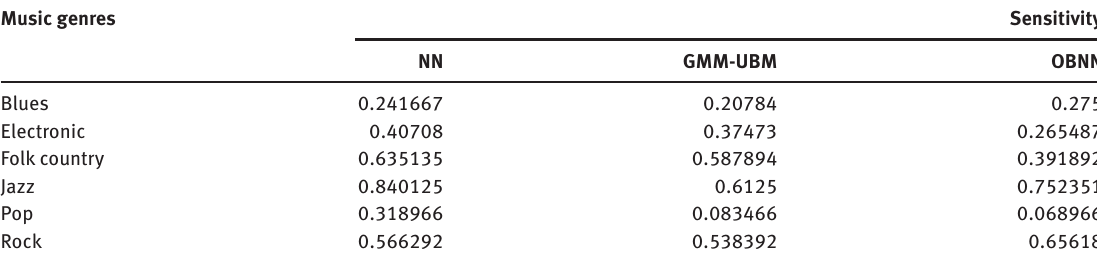
Table 2: Sensitivity Evaluation Results between NN, GMM-UBM, and